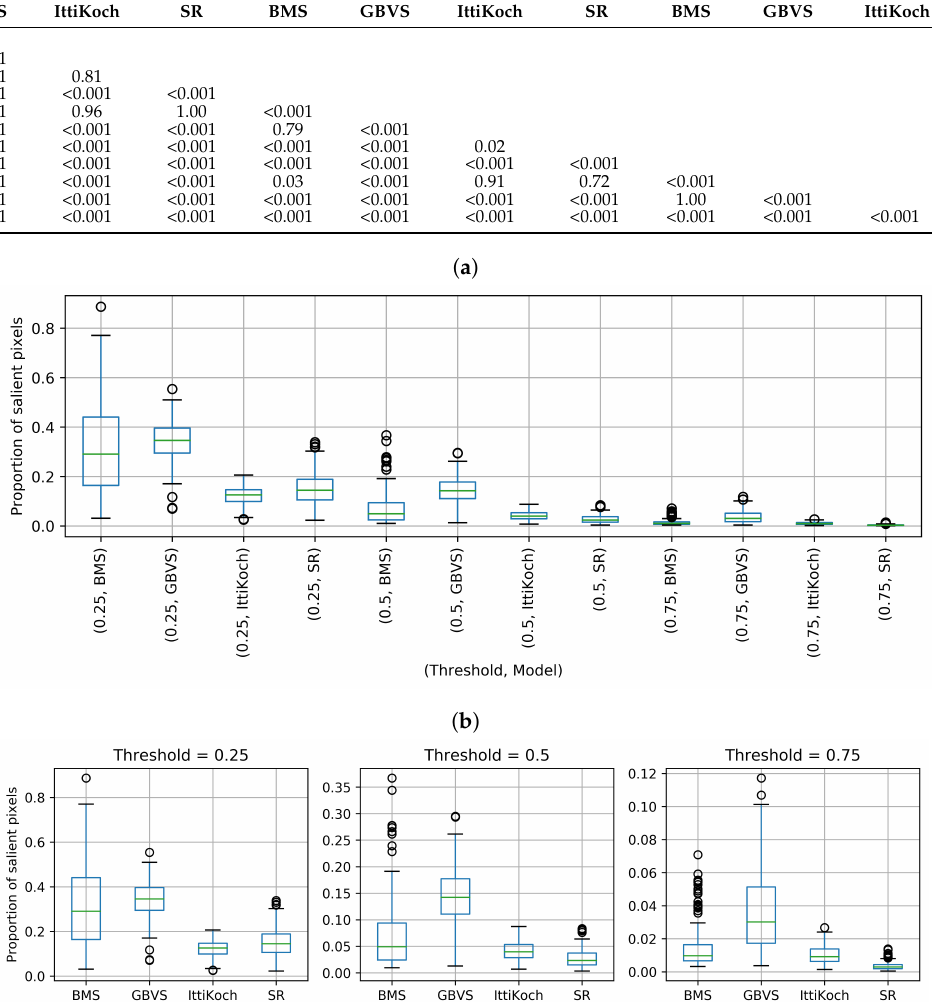
Table 4. p -Values obtained with a Nemenyi pairwise test for proportion of salient pixels over different saliency thresholds. Threshold 0.25